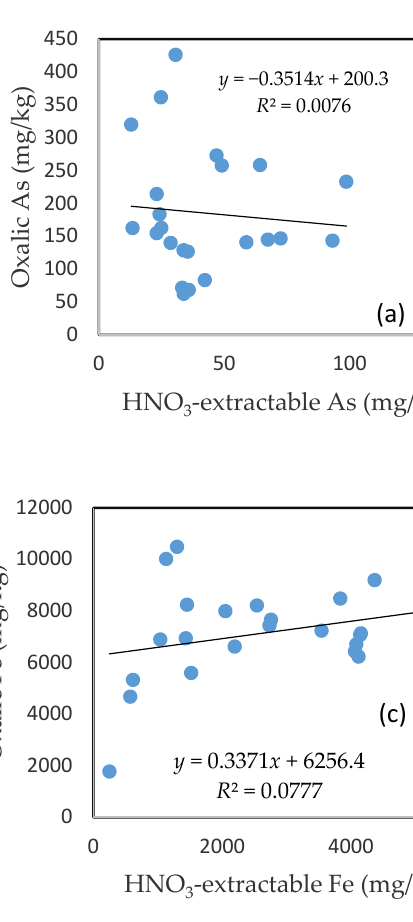
Figure 5. Relationship between the amount of Fe released from the soil and the rate of Zn mobilization in ( a ) acetic acid, ( b ) citric acid, ( c ) formic acid, ( d ) malic acid, ( e ) oxalic acid, and ( f ) tartaric acid